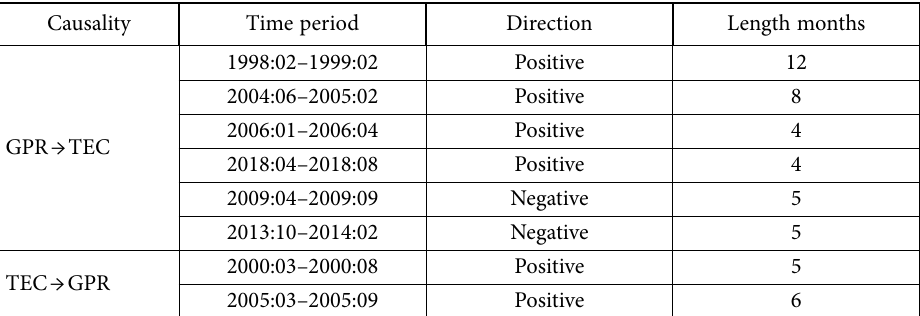
Table 6. Summary of the relationship between GPR and TEC Causality Time